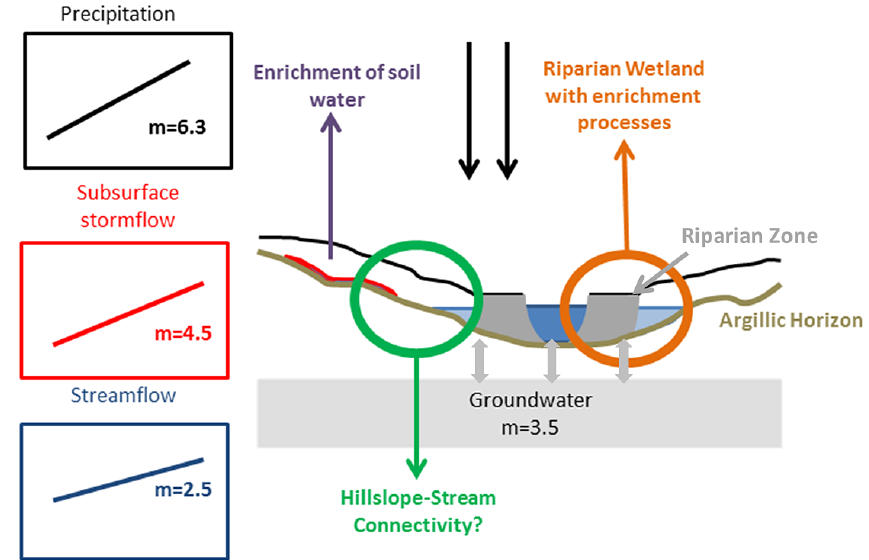
Figure 8. Conceptual model of baseflow runoff generation and enrichment in heavy isotopes from rainfall to streamflow. Key element is the disconnectivity between the hillslopes and the riparian-stream systems, which is likely sustained by precipitation and deeper